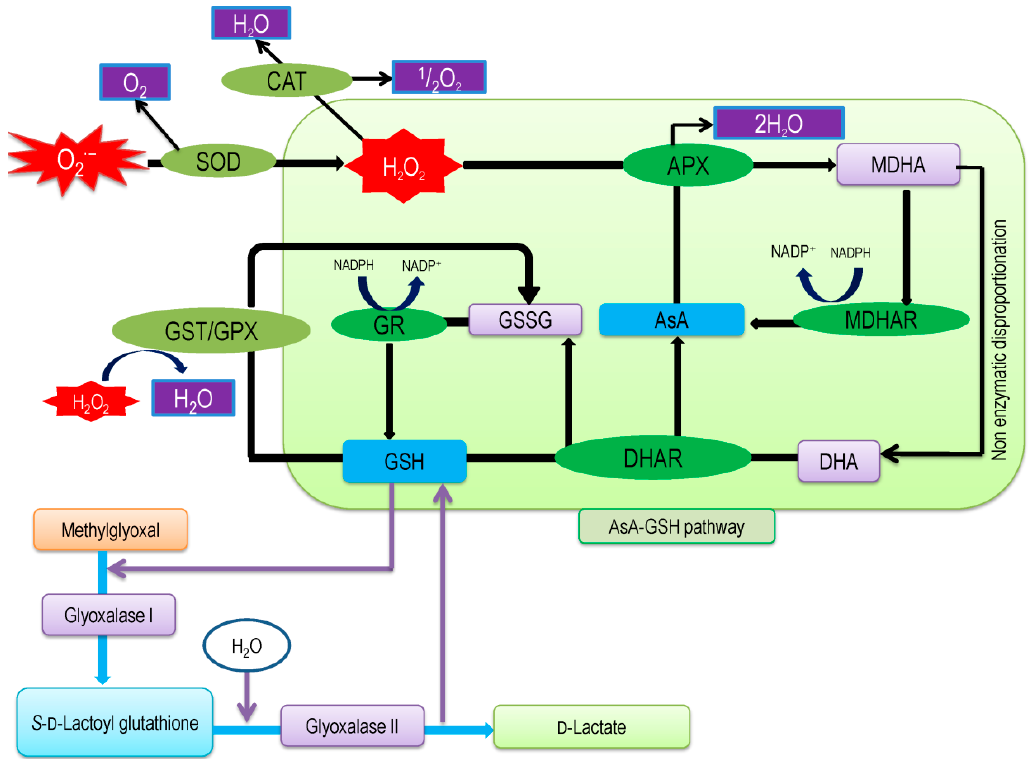
Figure 9. AsA-GSH pathway of the antioxidant defense system and its relation with the glyoxalase system. Additional details are in the text.